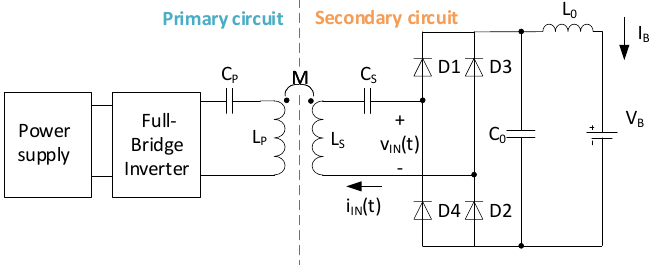
Figure 1. Series-series architecture of a wireless charger used in drone applications. C p and C s are the compensation capacitors, L p , L s and M are the self and mutual inductances of the coupled coils. D1, D2, D3 and D4 are the rectifier diodes, L 0 and C 0 constitute the second-order